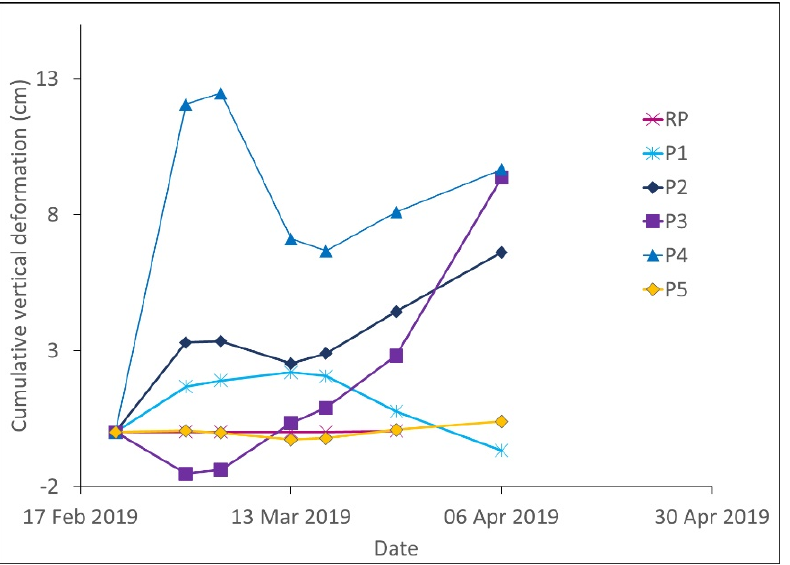
Figure 13. Sentinel-1 InSAR cumulative vertical deformation (up-down) from combined analyses of ascending (VV polarization) and descending (HH polarization) observations. + for upward defor- mation, − for downward deformation.